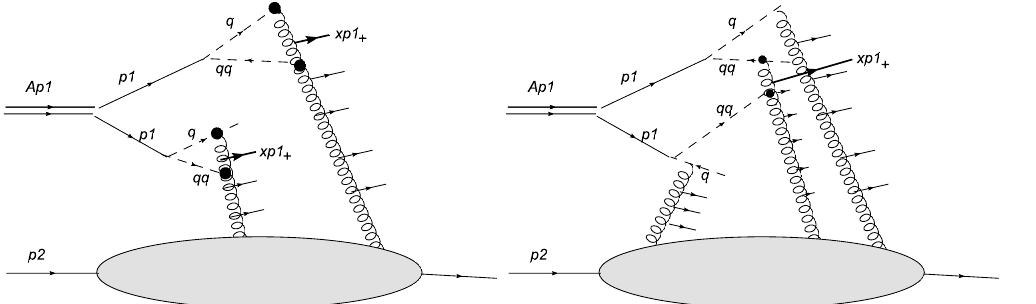
Figure 2. pA collision for A = 2 with creation of four color strings which fuse within individual nucleons ( left panel) or between different nucleons ( right panel). The nucleons of the projectile are shown by solid lines and the partons into which they split (quarks and diquarks) by dashed lines. Cumulative particles are shown by thick solid